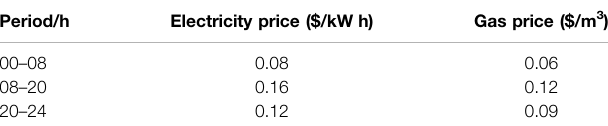
TABLE 3 | Price of electricity/gas/heat.